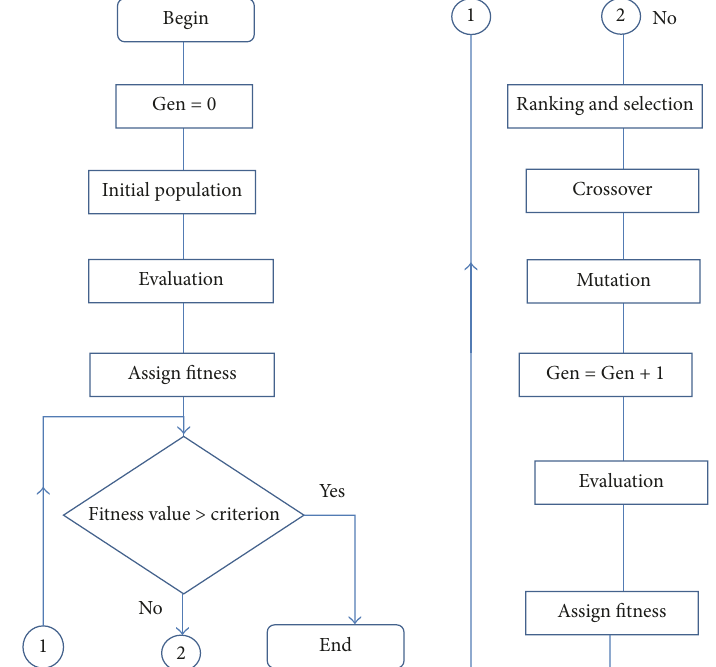
Figure 5: Flowchart of the basic genetic algorithm.